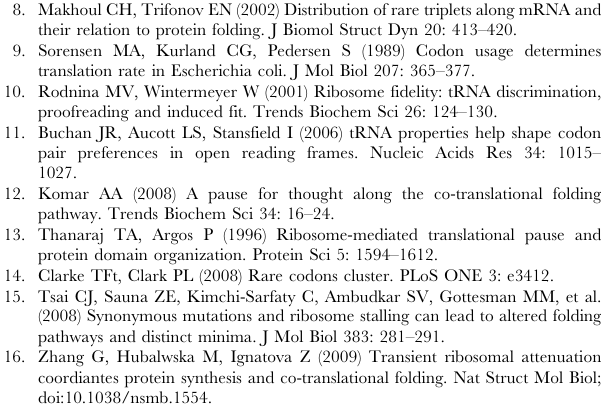
Figure S2 Correlation between codon usage and tRNA content for E. coli (A) and B. subtilis (B). tRNA concentration is plotted in relative units [1,2]. The correlation coefficients are: 0.57 for E. coli and 0.54 for B. subtilis. Figure S3 Examples of translation profile of some E. coli proteins. (A) Translation profile plots of ribosomal proteins. All ribosomal proteins are highly abundant with a copy number of 18700. (B) Translation profile plots of random E. coli proteins of various length (aa, amino acids) and copy number. Protein copy number is retrieved from http://redpoll.pharmacy.ualberta.ca/ CCDB/. Figure S4 Exonuclease III - another example of paralogous proteins with conserved attenuation pattern among the species. (A) Both E. coli and B. subtilis ORFs of endonuclease III possess a putative attenuation site (marked with a star) down-stream of the first helical domain (depicted in red). For detailed description of the translation profile plots see the legend to Fig. 1. The starting point of the translation attenuation site in B.subtillis endonuclease III is shifted by 10 amino acids, probably due to the variations in the peptide chain length that can be shielded in the ribosomal tunnel. (B) Crystal structure of the E. coli endonuclease III (pdb- code: 2ABK). The two proteins show 43% and 49% identity at the amino acid and DNA level,